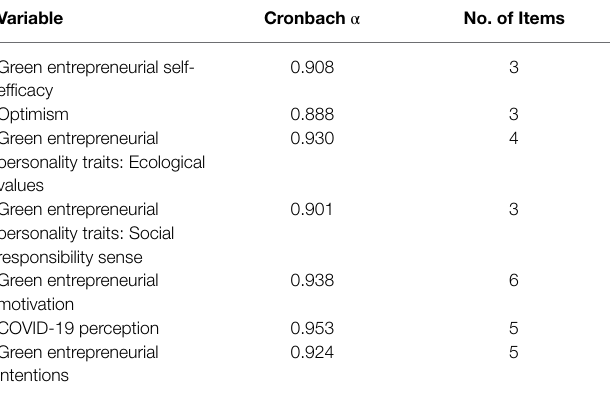
TABLE 1 | The results of reliability test.